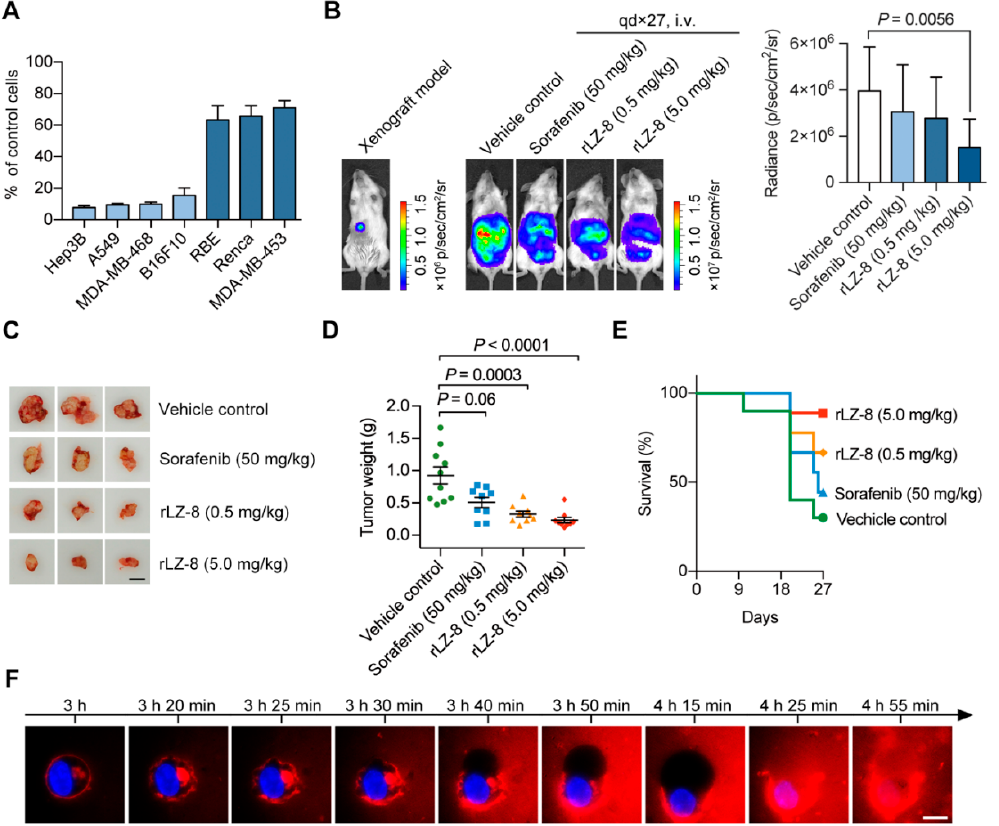
Figure 1. rLZ-8 could cause tumor cell death in vivo and in vitro. ( A ) Effect of rLZ-8 on the cell viability in vitro were detected after 48 h rLZ-8 incubating. ( B–E ) Hep3B cells were grown as orthotopic xenografts. Mice were divided into groups and dosed with normal saline control, 50 mg/kg Sorafenib or rLZ-8 with different concentrations. n = 9 per group. All mice were fed for 27 days. ( B ) Representative bioluminescence images obtained at day 0 or 27. ( C ) Images of HCC tumors dissected at 27 d post inoculation. All tumors of survival mice were imaged in every group. Bars, 1 cm. ( D ) Tumor weights were measured after dissection. ( E ) The survival status of mice was observed every day. ( F ) Hep3B cells real-time imaging began from 100 µ g / mL rLZ-8 (red) treating for 3 h. Cell nuclei were dyed by Hoechst (blue). Representative images of death process were shown in this panel and the video of whole process was shown in Video S1. Scale bars, 10 µ m. All data in A, B and D are means ± SD; two-tailed Mann-Whitney test. p -values as shown in panels.